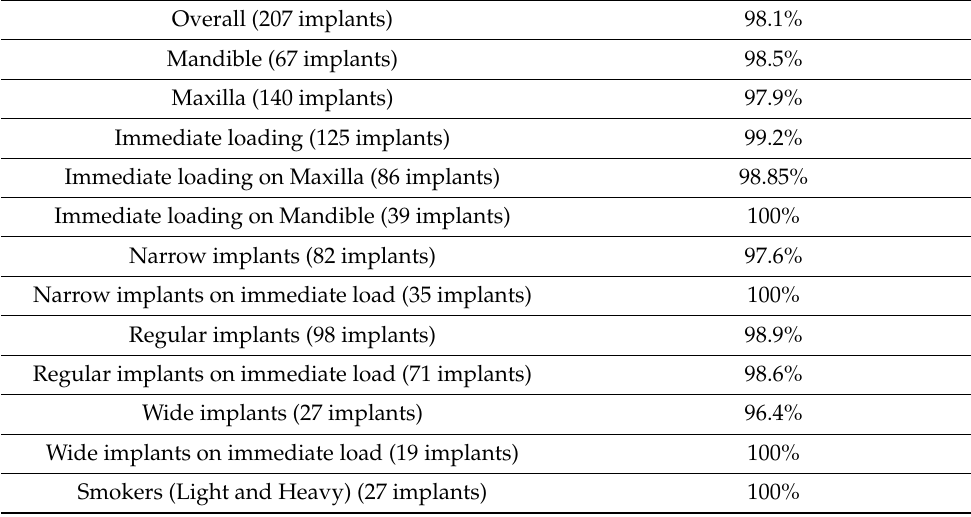
Table 2. Survival rates of dental implants according to subgroups.